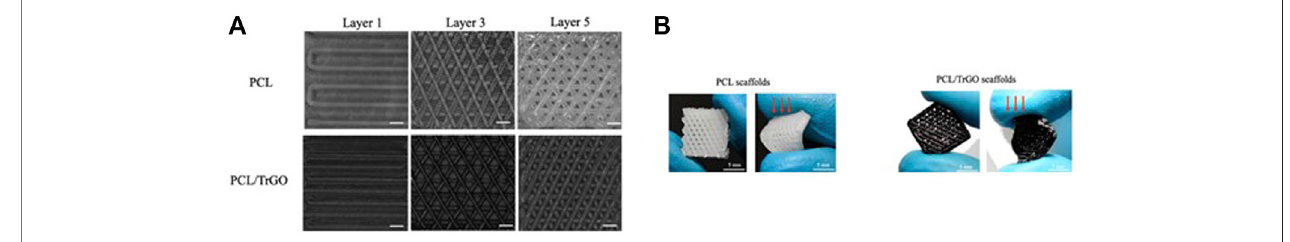
FIGURE 8 | The development of PCL/ TrGO scaffold. (A) Images obtained during scaffold printing processes at layers 1, 3, and 5. Scale bar: 300 μ m, and (B) optical imaging of the frontal scaffold viewpoint (left) and after exerting qualitative stress (right). Images (A, B) were adapted from Angulo-pineda et al. (2020) under